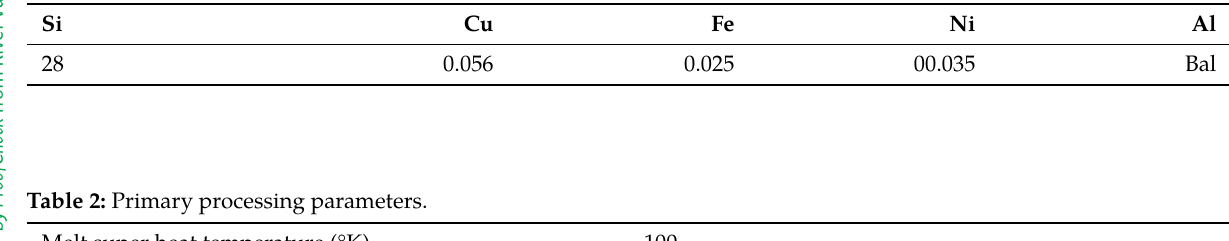
Table 1: Chemical compositions (wt %) of Al-28Si alloy.